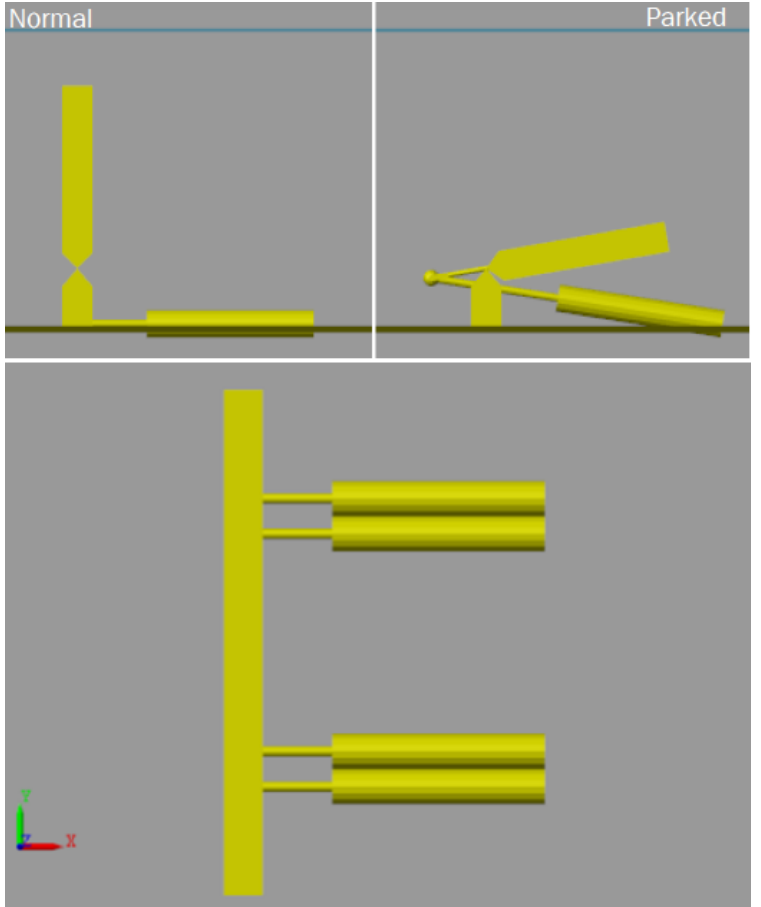
Figure 1. Views with rest and extended PTO conditions of the IMAGINE OWSC model (IMAGINE project,